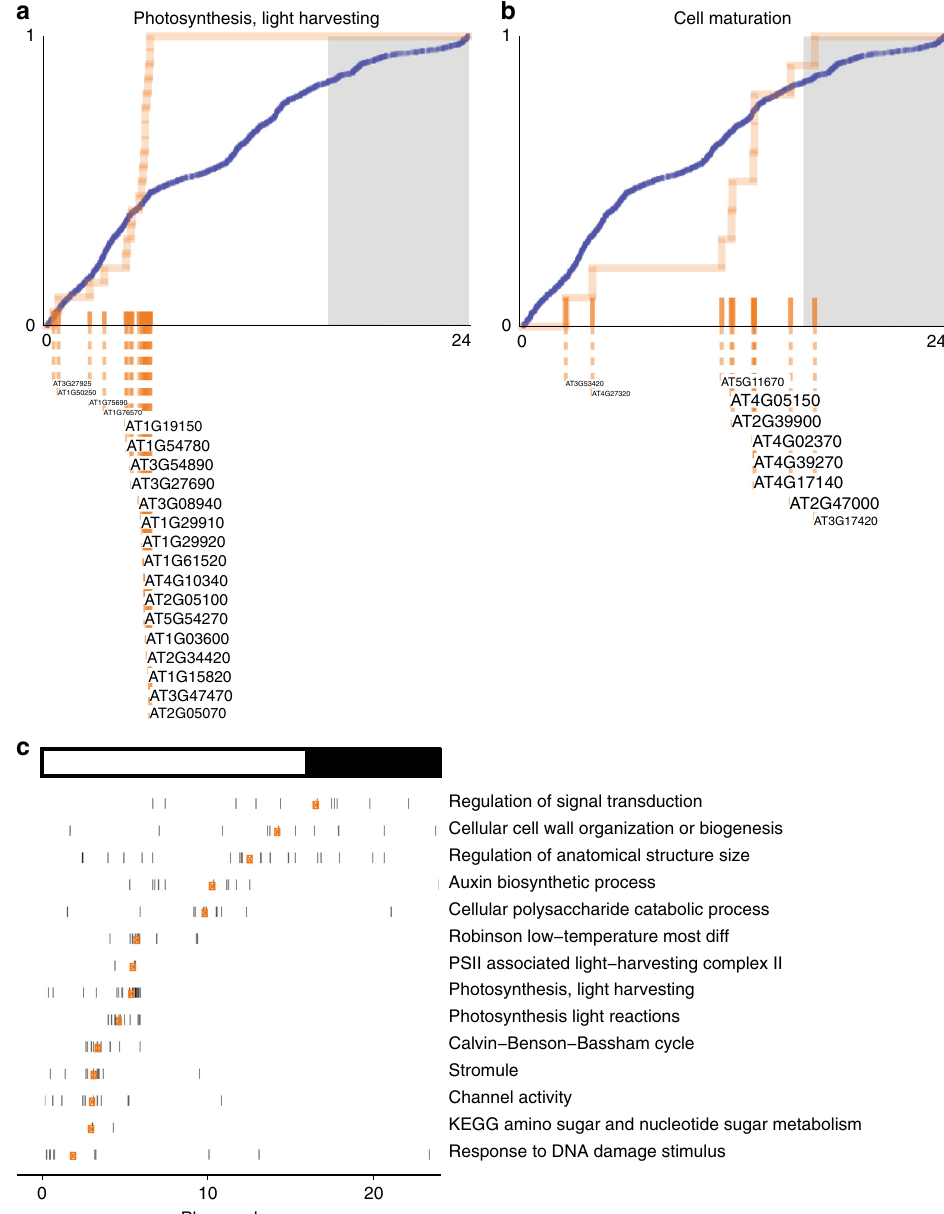
Fig. 4 Phase set enrichment analysis of the genes with oscillating TCR. Cumulative distributions (to 100%) of the genes associated with a Photosynthesis, light harvesting and b Cell maturation categories (orange). The cumulative distributions are signi fi cantly different from the background (1453 genes with TCR oscillation, blue) based on the Kuiper test ( q < 0.05). c Phase values of the genes involved in speci fi c pathways. Each vertical bar represents a gene phase value which is aligned with the x -axis. Orange points represent the median phase values of the genes for each